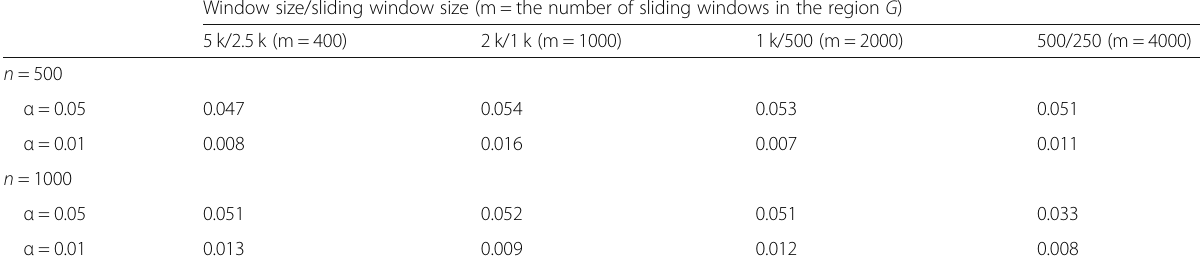
Table 1 Type I error estimates with Bonferroni correction Window size/sliding window size (m = the number of sliding windows in the region G